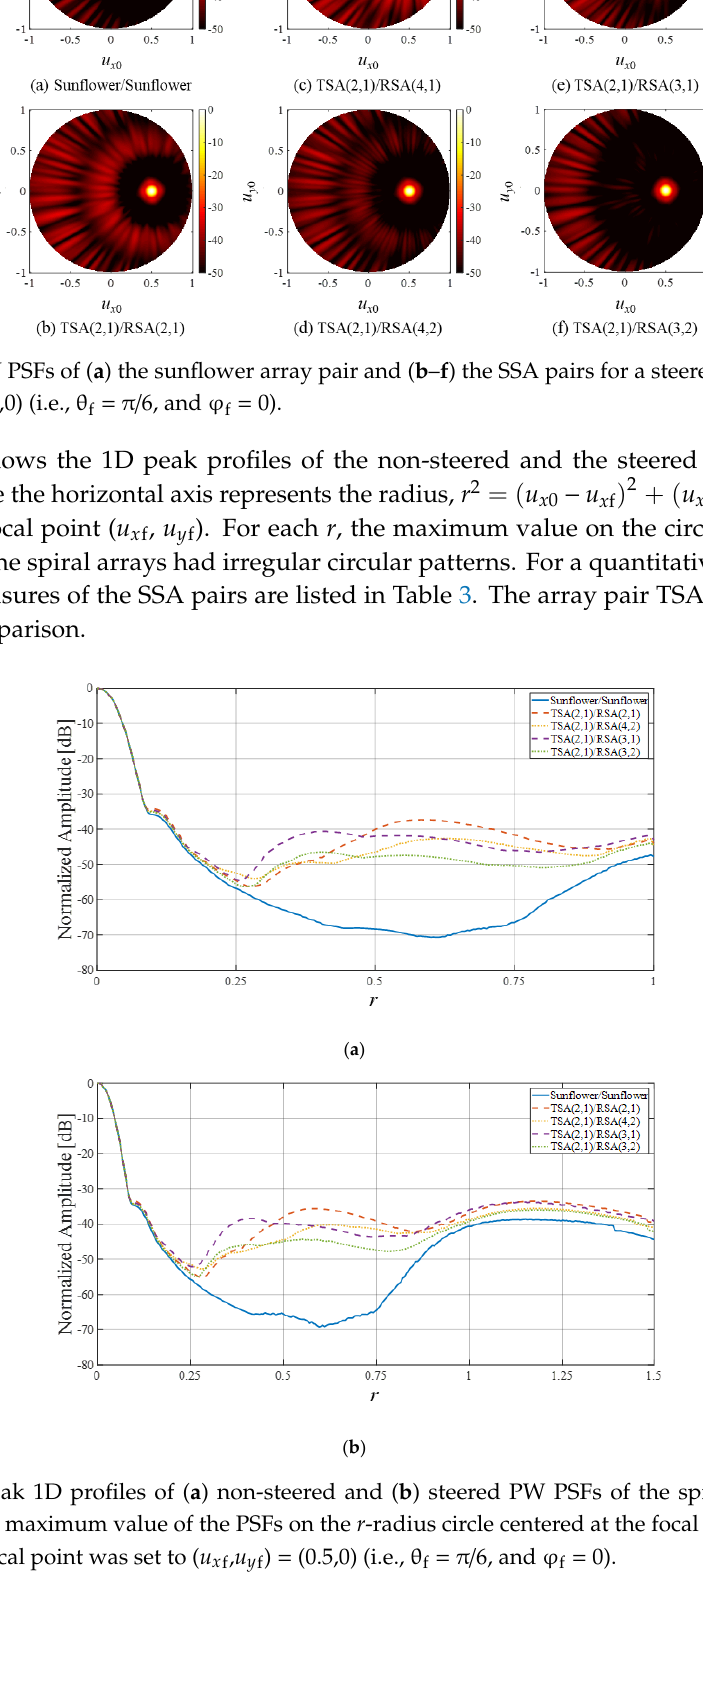
Figure 14. Two-way, PW PSFs of ( a ) the sunflower array pair and ( b – f ) the SSA pairs.